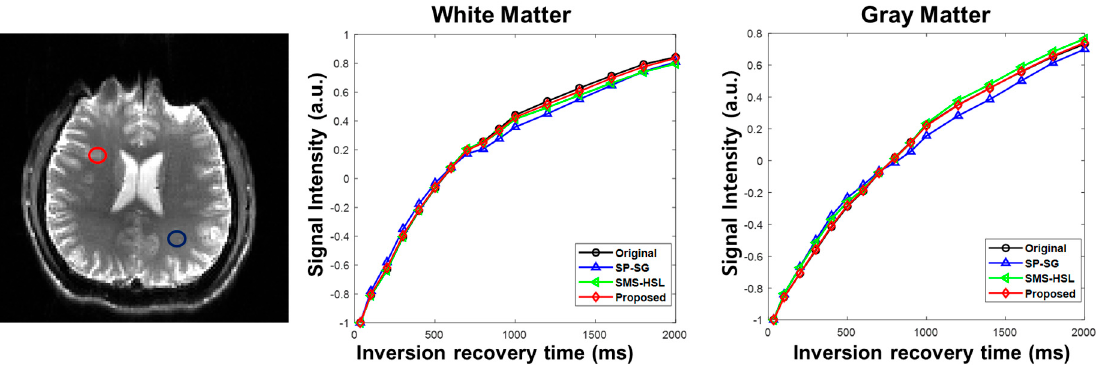
Figure 5. T1 signal intensity curves of white and gray matter regions. The curves are generated from the reference and the reconstructed images by averaging the voxels in each region of interest. The signal curves from the proposed method strictly follow the decay curves of the reference, SP-SG and SMS-HSL.